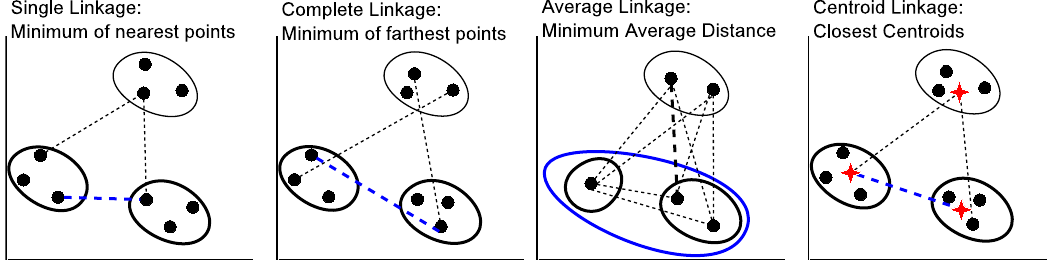
Fig 3. Various linkage metrics for hierarchical clustering. The dashed lines are the linkage between clusters and highlighted edge shows the optimal linkage for clustering.